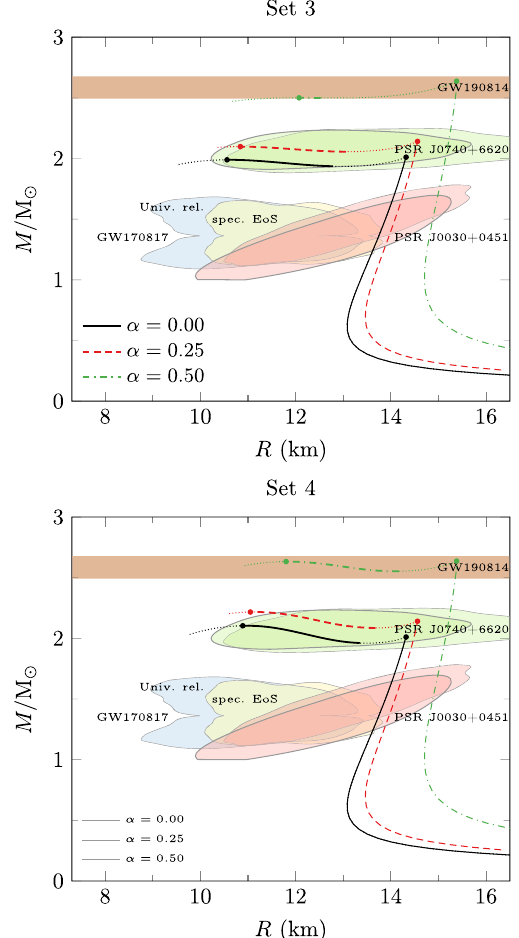
Fig. 4 Predictions of the MP model for the mass–radius profile of charged twin stars considering sets 3 and 4. The results for the neutral counterparts are also presented for comparison